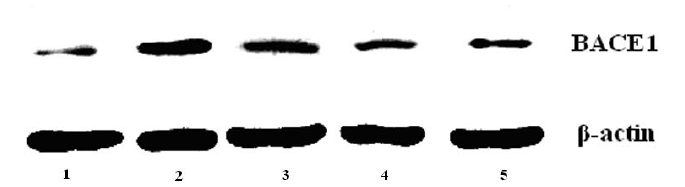
1 – 2 represent the protein expression in normal and control groups, respectively; 3 – 5 represent the proteins expressions of groups treated with curculigoside at the doses of 10, 20 and 40 mg/kg/day,